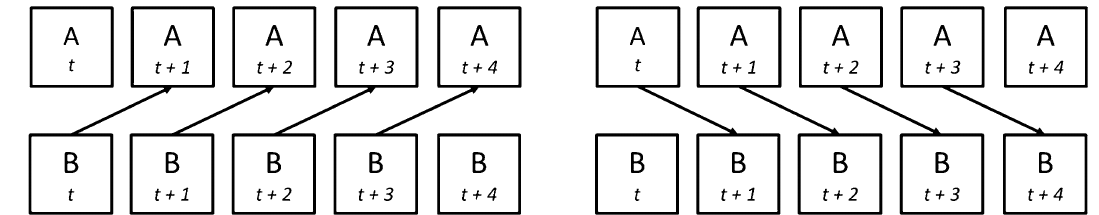
Figure 2. Physiological linkage for a dyad of Persons A and B over 5 min. ( Panel 1 ) shows that Person A (as the “receiver”) has a linkage score that represents how much Person A’s physiological response at minute t + 1 is predicted by the physiological response of Person B (as the “sender”) at minute t , on average, throughout a group session. ( Panel 2 ) shows that Person B also has a linkage score with Person A that represents how much Person B’s response at minute t + 1 is predicted by Person A’s response at minute t